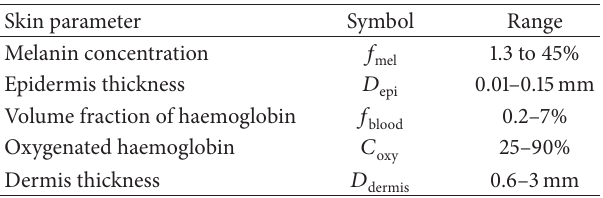
Table 1: Five skin parameters used in the retrieval algorithm. The range of each parameter is selected from the literature. The retrieval parameters are bounded to these limits. Skin parameter